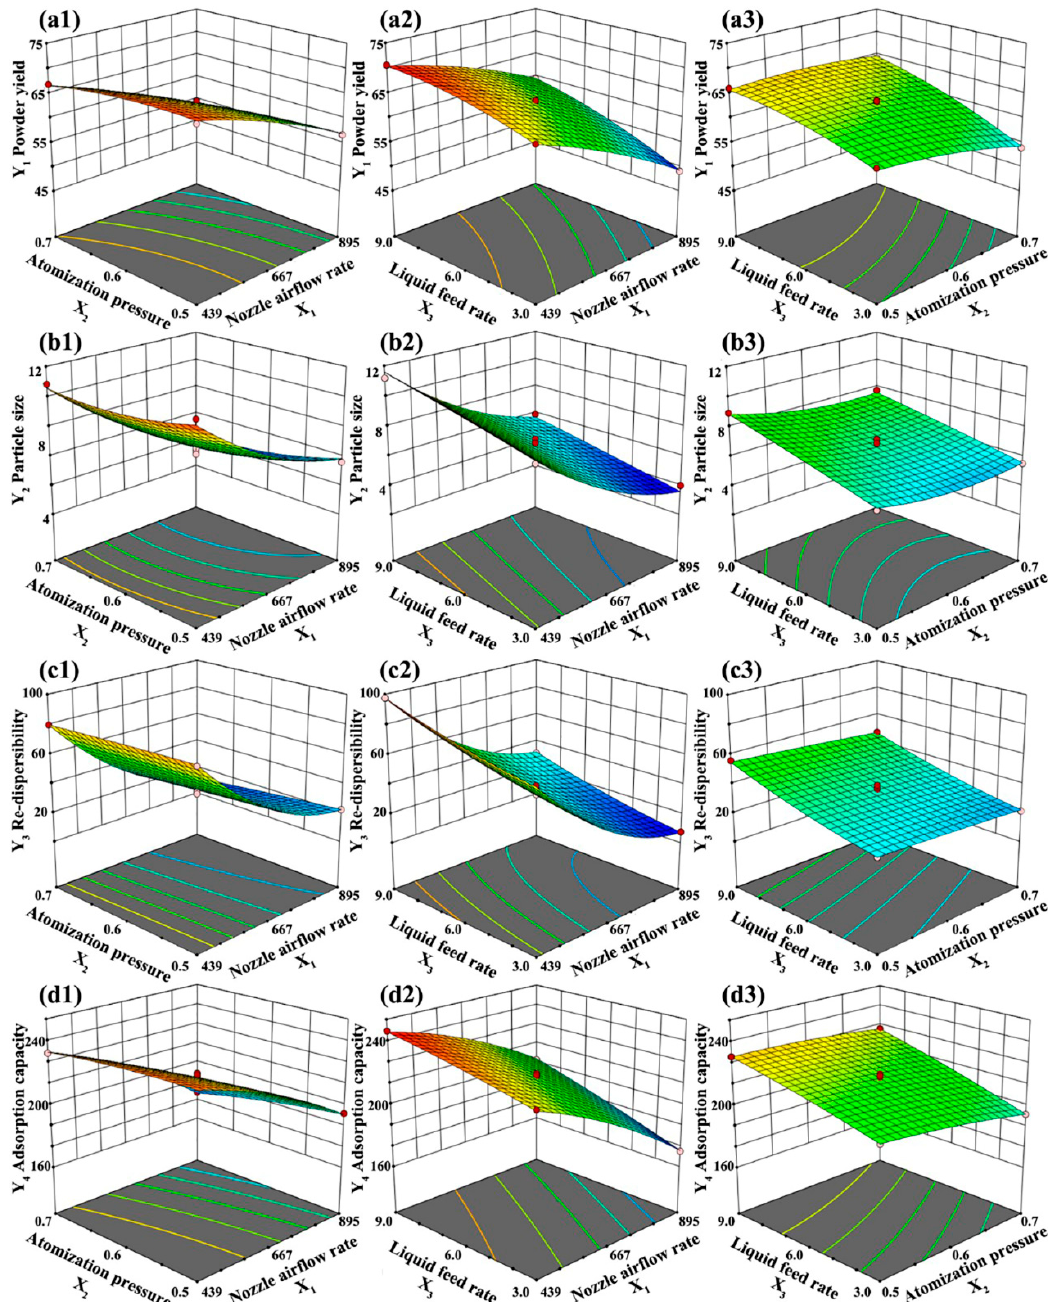
Figure 5. Surface plots for statistical models of the influence operating parameters on ( a1 – a3 ) powder yield Y 1 , ( b1 – b3 ) particle size Y 2 , ( c1 – c3 ) re-dispersibility Y 3 , and ( d1 – d3 ) adsorption capacity Y 4 against all operating parameters.